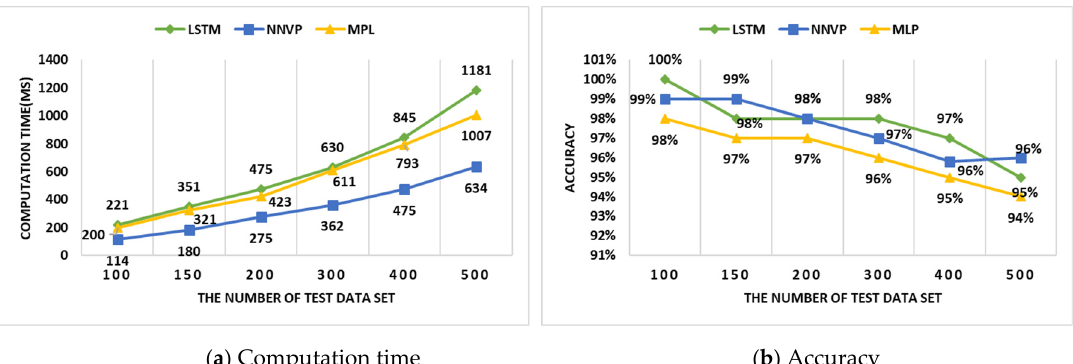
Figure 14. The ( a ) computation time and ( b ) accuracy according to test data.